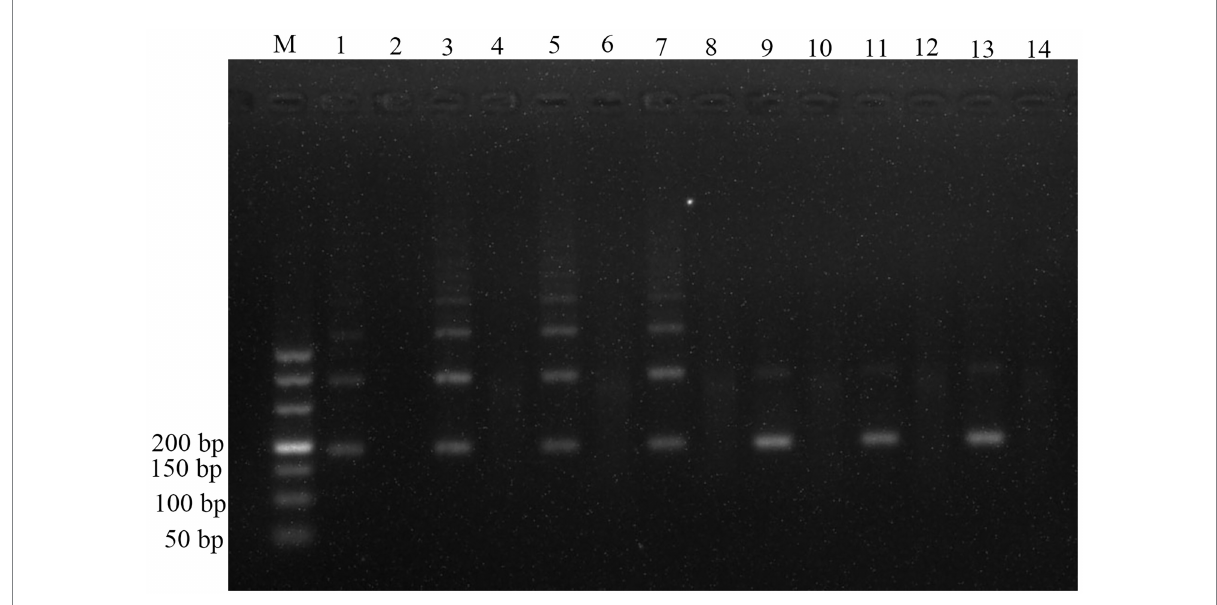
FIGURE 1 Optimization of reaction temperature for the RPA assay. Lane M: DL500; lane 1: 25 ° C; lane 3: 30 ° C; lane 5: 33 ° C; lane 7: 35 ° C; lane 9: 37 ° C; lane 11: 39 ° C; lane 13: 42 ° C; and lanes 2, 4, 6, 8, 10, 12, 14 were the negative controls (NTC) corresponding to the reaction